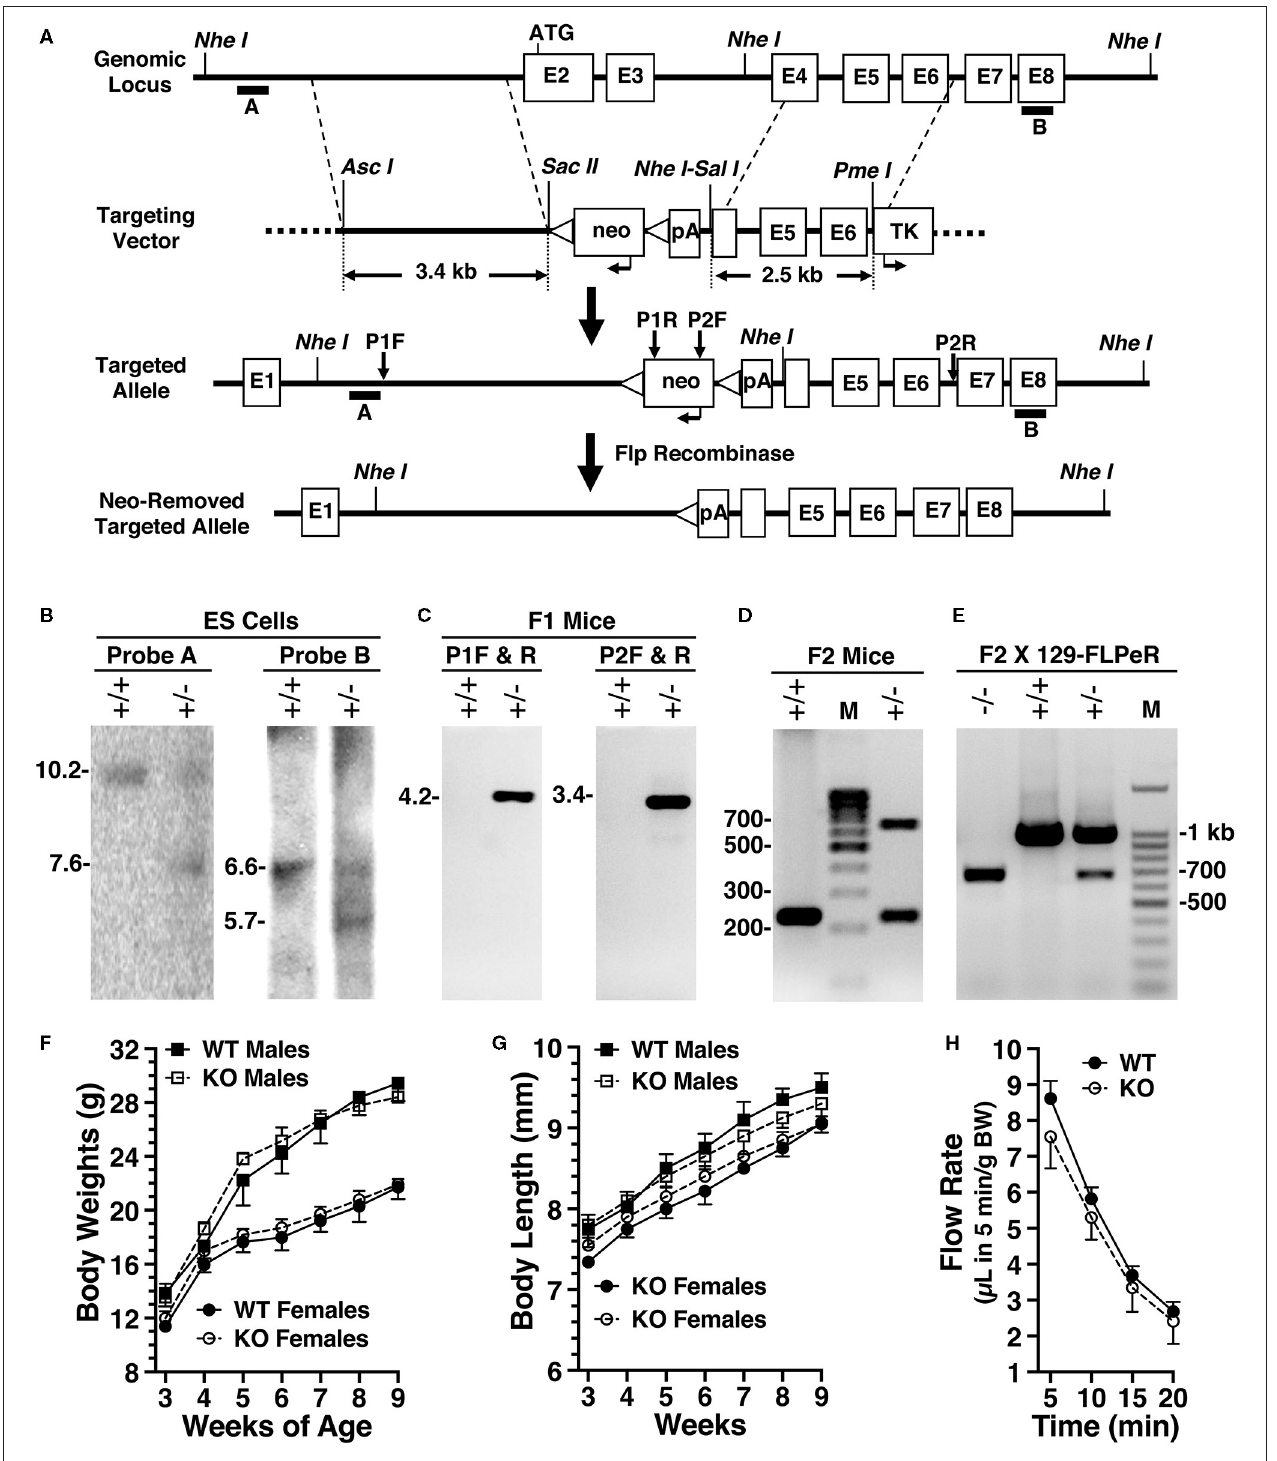
FIGURE 2 | Production and initial characterizations of Amy1 knockout mice. (A) The targeting vector used a base vector (pKOpA) created by the Gene Targeted Mouse Service from pBluescript II KS (Agilent Technologies, La Jolla, CA, USA). This vector incorporates a selection cassette encoding the neo gene under control of the herpes simplex virus–thymidine kinase promoter with two flanking FRT sites ( triangles ) and with an adjoining downstream SV40 polyA (pA). Also included is a negative selection marker, thymidine kinase, under control of the mouse phosphoglycerate kinase 1 promoter (TK). Homologous arms were PCR amplified from 129/Sv genomic DNA and cloned into pKOpA. Asc I and Sac II were used to clone the left arm; Sal I and Pme I, the right arm. Recombination excised exon 2, the translational start site, in addition to exon 3 and the 5 ′ portion of exon 4. Note: not drawn to scale. (B) Southern blot analyses of DNA from